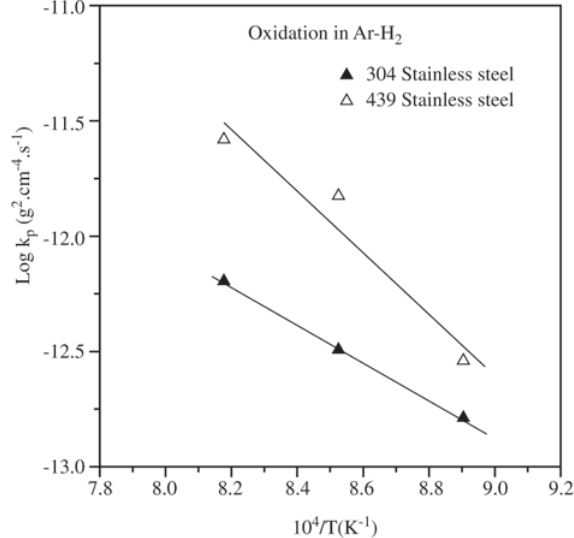
Figure 11. Arrhenius plot of the parabolic oxidation constants of 304 steel in oxygen and in Ar-H